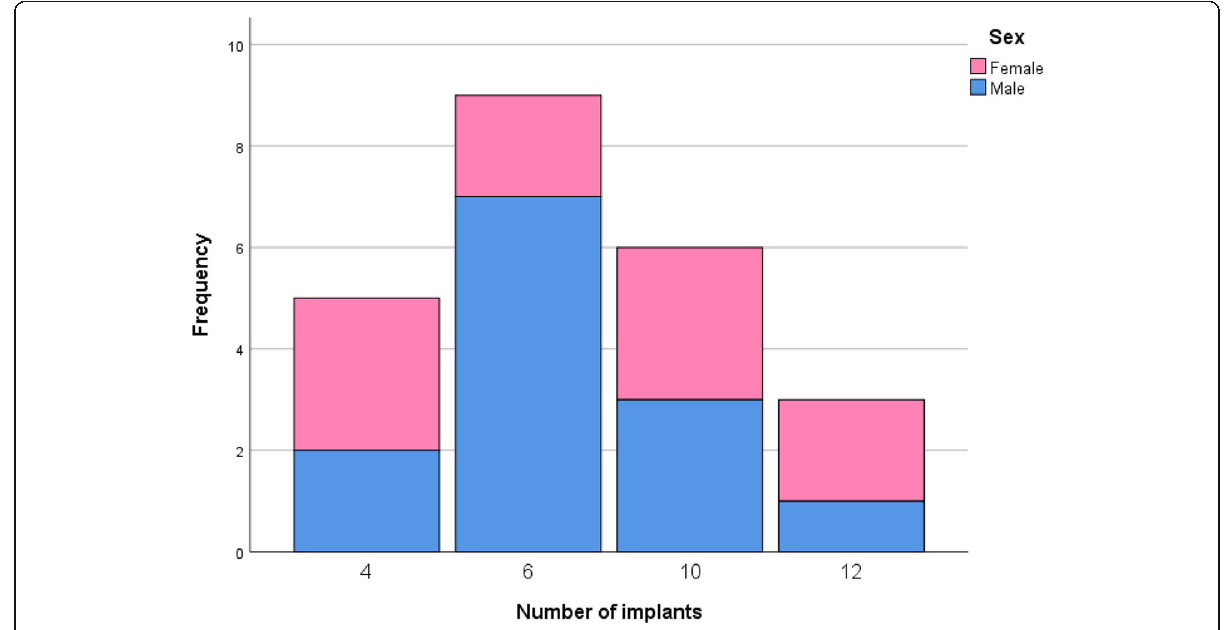
Fig. 1 Distribution of frequency by number of implants, divided in female and male. Most patients received 6 implants (9